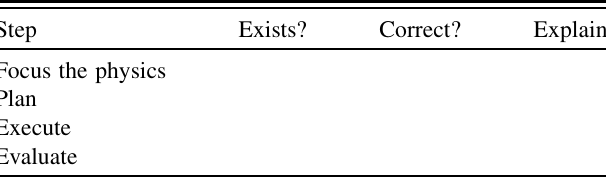
TABLE VI. Solution diagnosis form. Step Exists? Correct? Explain Focus the physics Plan Execute